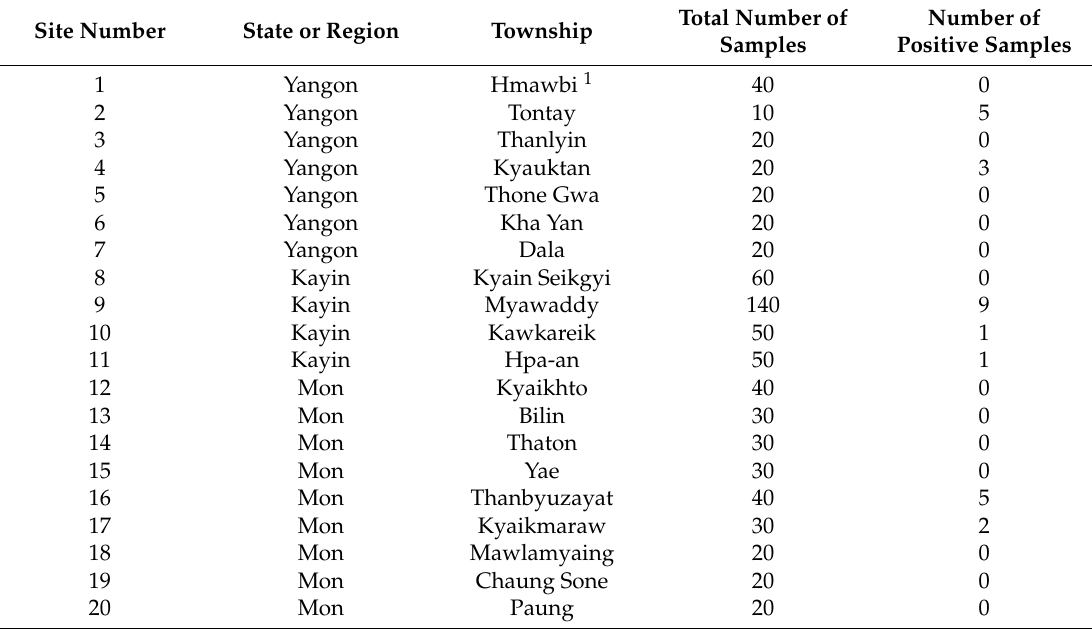
Table 2. Preliminary results of a soil survey being conducted in